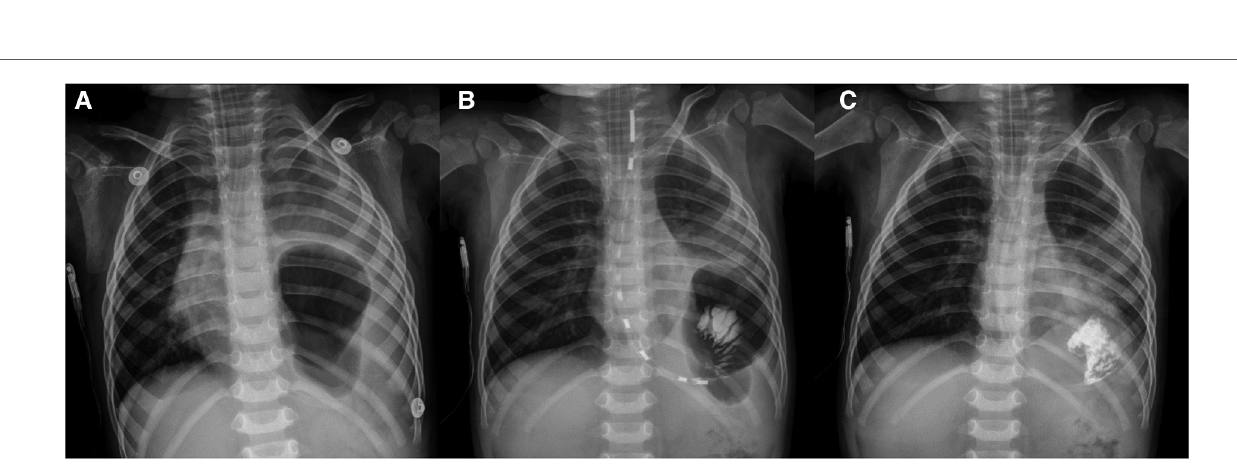
FIGURE 3 Case 3: x-ray manifestations before and after operation: ( A ) encapsulated gas accumulation with mediastinal displacement; ( B ) the gastric tube is not bent, and its distal end is located in the stomach; ( C ) after adjusting the gastric tube for the complete decompression, there was no encapsulated gas accumulation with mediastinal displacement.